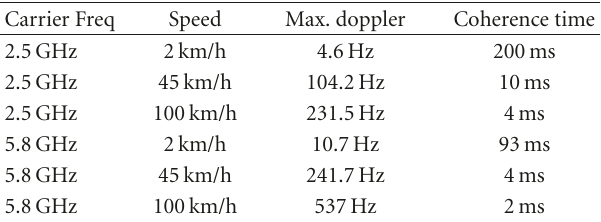
Table 2: Typical Doppler spreads and coherence times for